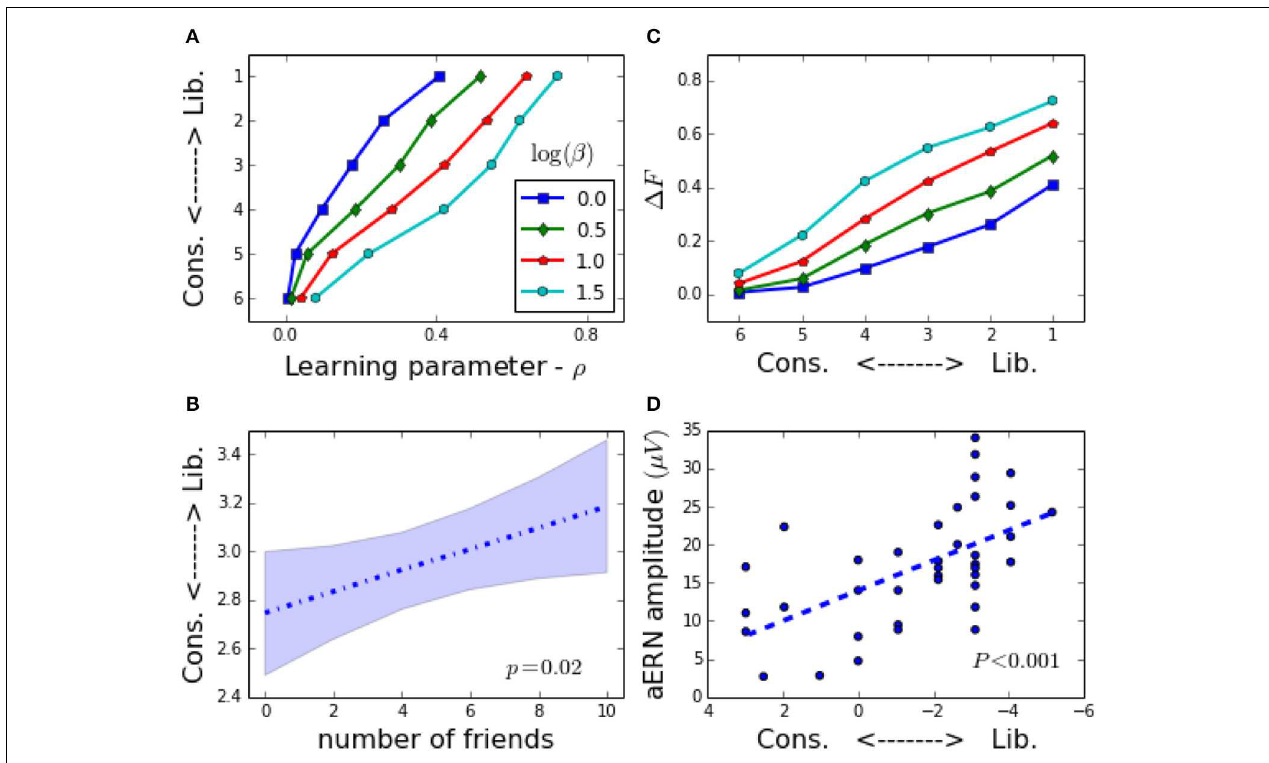
FIGURE 3 | Model vs. data. Model results: Panels (A) and (C) show results from the model. Panels (B) and (D) are observational results from data published in Settle et al. [ 35] and Amodio et al. [ 28], respectively. (A) Model: Political affiliation (pa = 1-Liberal, pa = 7-Very Conservative) is correlated to ρ , which is a measure of the number of social information exchanges in the formative phase of the agents’ lives. This occurs for a wide range β values. (B) Data: